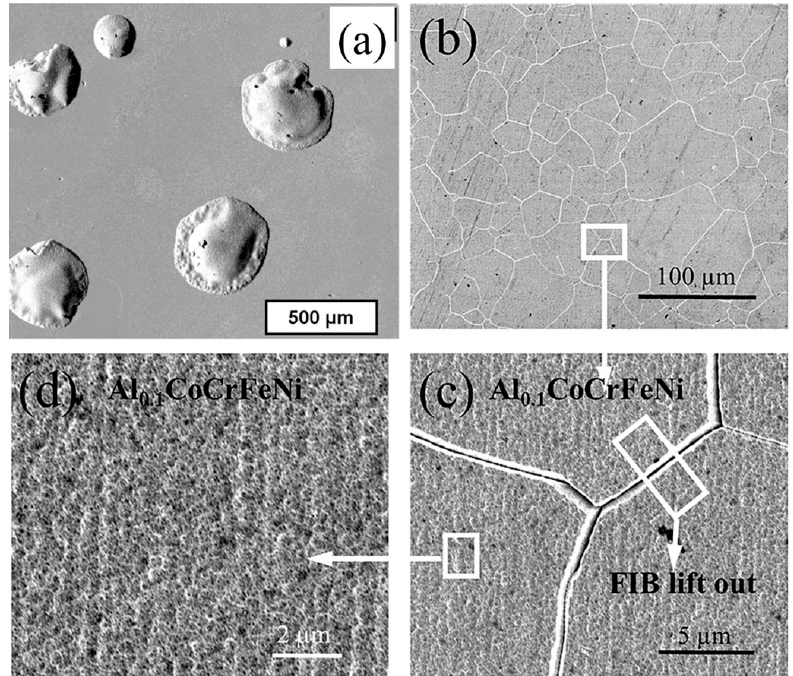
Figure 5. Pitting morphologies in Al 0.1 CoCrFeNi alloy after polarization test in 3.5% NaCl [32]. ( a ) large pitting on the sample when tested to current density of 10 mA/cm 2 ; ( b ) low magnification image showing grain boundary corrosion; ( c ) high magnification image showing grain boundary corrosion and micro-porosity formation; ( d ) high magnification image showing small micro-porous structures on the surface after corrosion [31] (reprinted with permission from